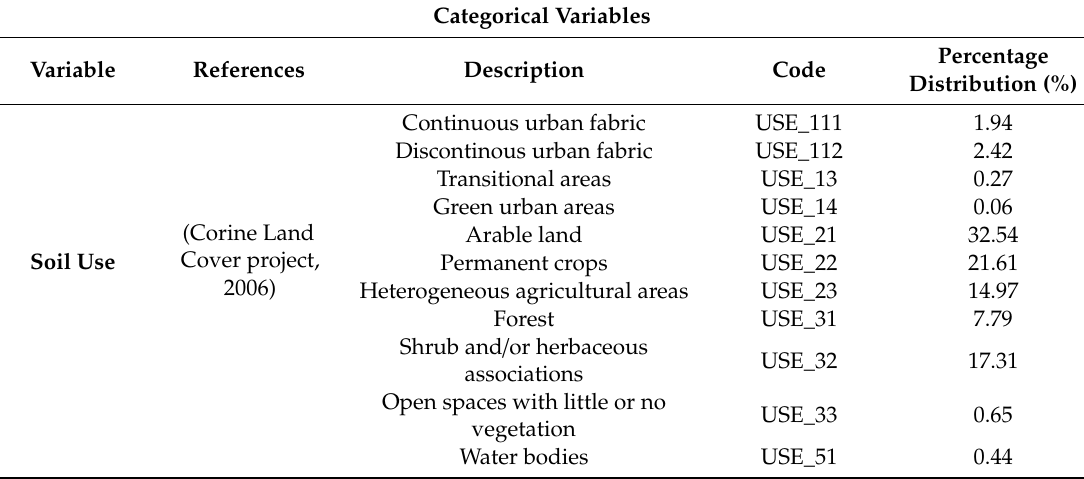
Table 2. Geo-environmental factors and their spatial